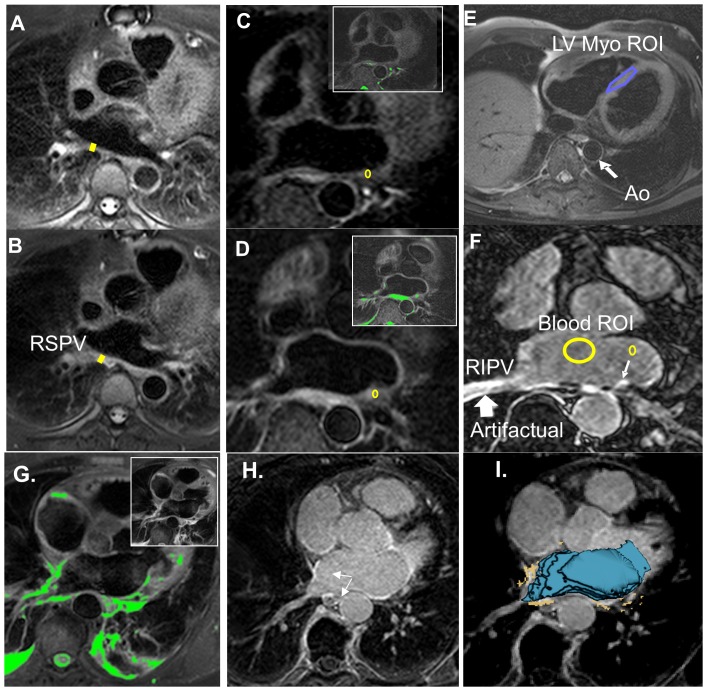
Methods of data analysis.A-B) T2W images from a subject imaged pre pulmonary vein isolation (PVI) (A) and 24-hour post PVI (B), used for measuring right superior PV wall thickness, as shown; note the prominent LA wall thickening. C-F) Another subject imaged pre-pulmonary vein isolation (PVI), 24-hour post-PVI, and 30-day post-PVI. C) Pre-PVI T2W image. D) 24-hours post -PVI T2W image shows enhancement where none is observed pre-PVI. Colored insets highlight regions where signal exceeds the edema threshold in C and D. ROIs were placed on the T2W images, as shown in (C, D). E) Axial T2-weighted (T2W) image at the level of the mid left ventricle (LV) with the region of interest (ROI) used for calculating the edema threshold (defined as 1.4 times the mean LV myocardium signal). F) Late gadolinium enhancement (LGE) 30-days post-PVI demonstrating scar. A left lower PV wall ROI, and blood pool ROI are shown. G) Color) Early post-PVI, the T2W image shows enhancement. Regions above the EER threshold (1.4) are highlighted in green. H) 30-day LGE appears to correlate 24-hour T2W. I) By registration of 24-hour T2W and 30-day LGE, the correlation between acute edema and later scar is more easily quantified, using matched ROIs. The blue shell represents the LA cavity segmented from the 30-day LGE images. The segmented edema (orange) is overlaid on the 30-day LGE image.